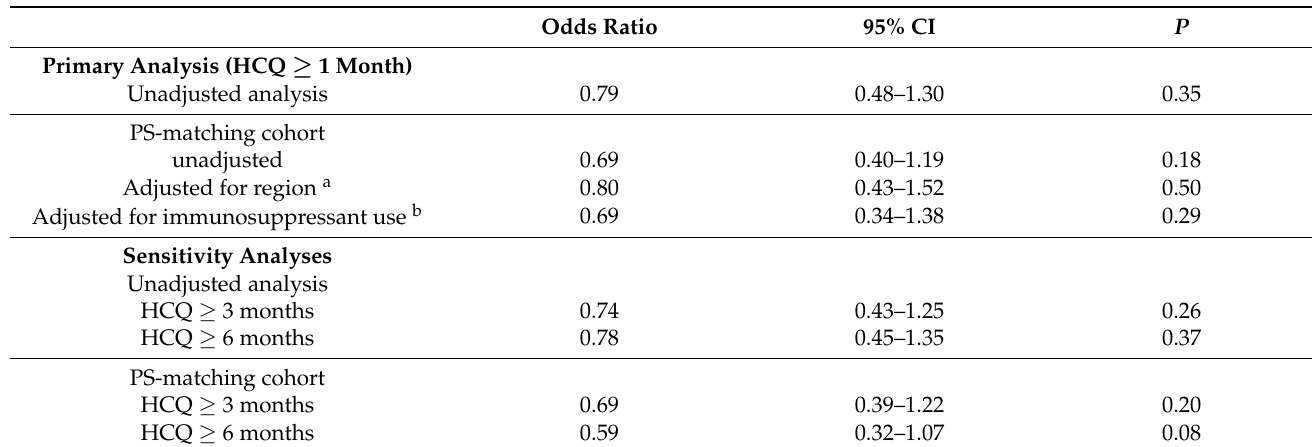
Table 3. Likelihood of positive test for SARS-CoV-2 according to treatment with HCQ. Odds Ratio